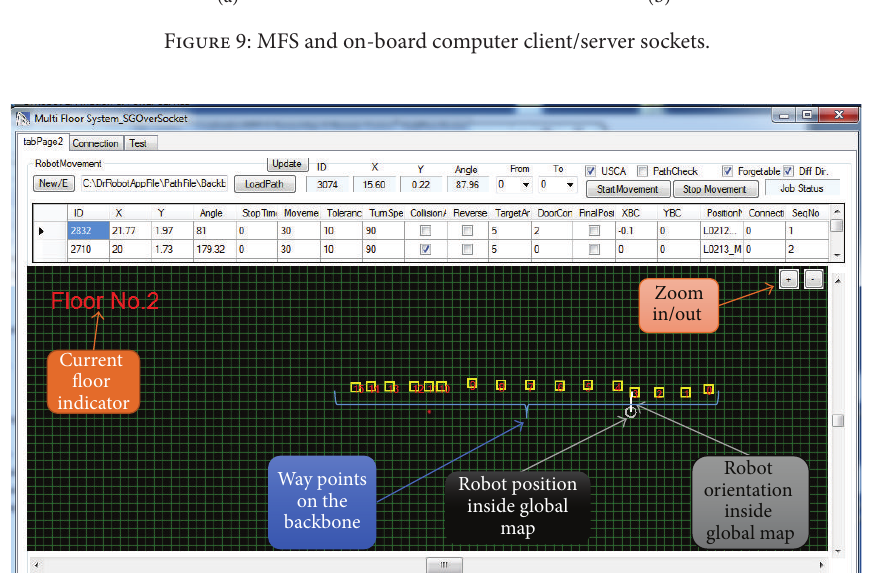
Figure 10: Multifloor GUI.